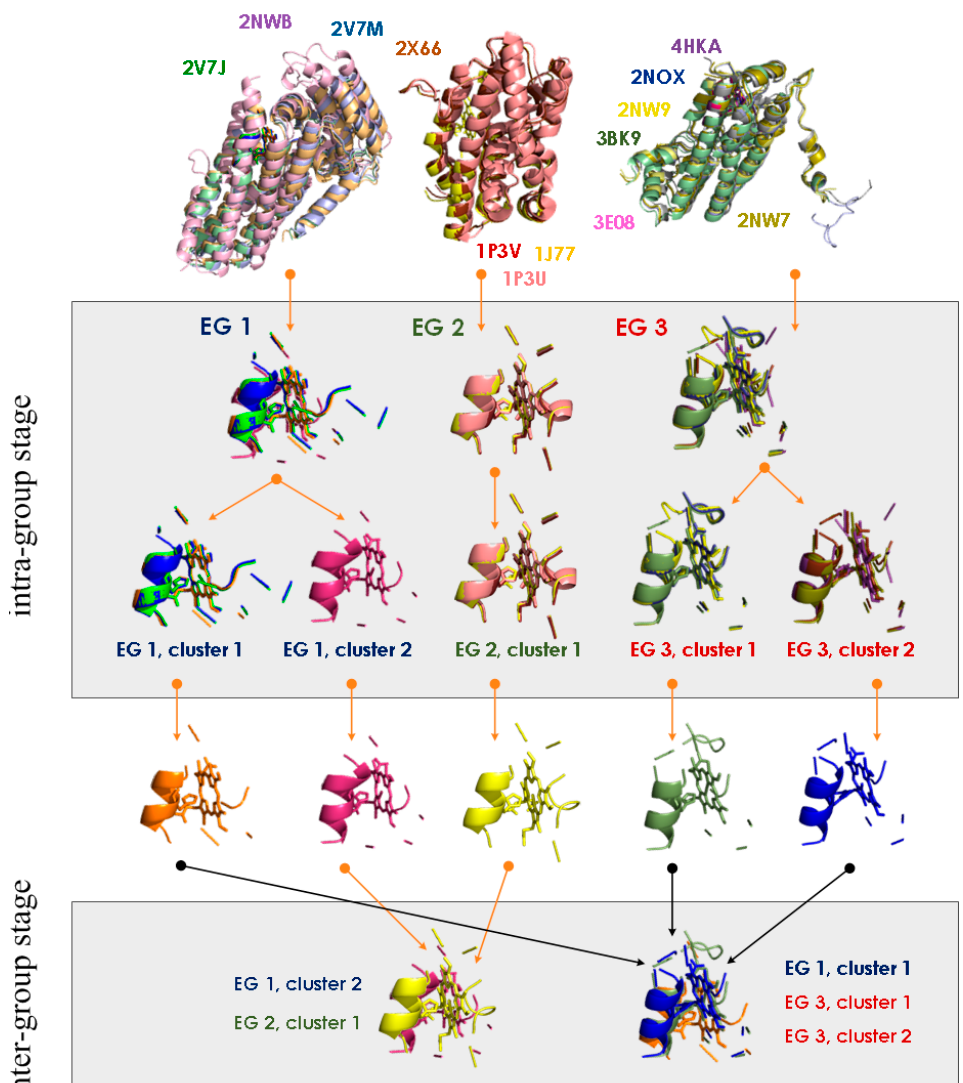
Figure 6. MetalS 2 -based clustering of heme-binding MFSs. Each protein structure and its MFS correspond to a different color in all panels. The PDB codes in the top panel show the color scheme used. All MFSs are extracted from the equistructural groups (EG) in the MetalPDB database that contain a heme-binding site (exemplified by EG 1, EG 2, EG 3 in the top row). The MFSs within each EG are clustered using a stringent threshold for the MetalS 2 score (2.25 in the present example [16]). Consequently, MFSs from a given EG can be grouped in one or more clusters (EG1 and EG 3 give rise to two clusters each, whereas all MFSs in EG 2 are clustered together). This is the intra-group stage. Then, for each cluster a single representative is identified, as the MFS with the lowest cumulative distance ( i.e. , sum of MetalS 2 scores from all other MFSs in the cluster). The representative MFSs are finally clustered with a less stringent threshold and using a more relaxed hierarchical clustering approach (average rather than complete clustering). This is the inter-group stage. This clusters the MFSs regardless of the initial EG, thus putting together MFSs originally extracted from metalloproteins with different folds. This Figure was taken from [59].